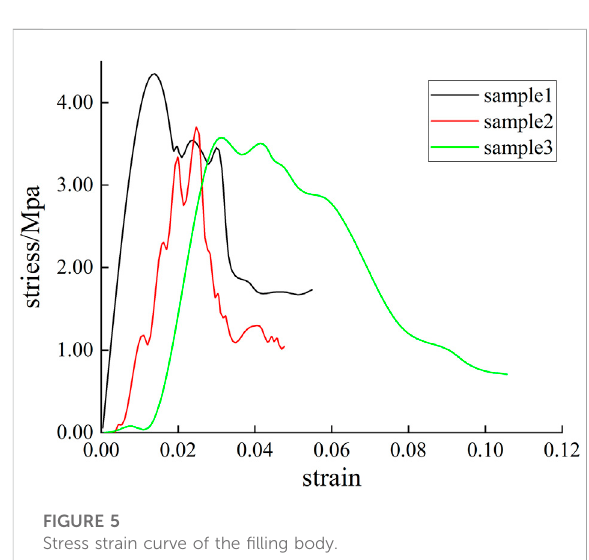
FIGURE 5 Stress strain curve of the fi lling